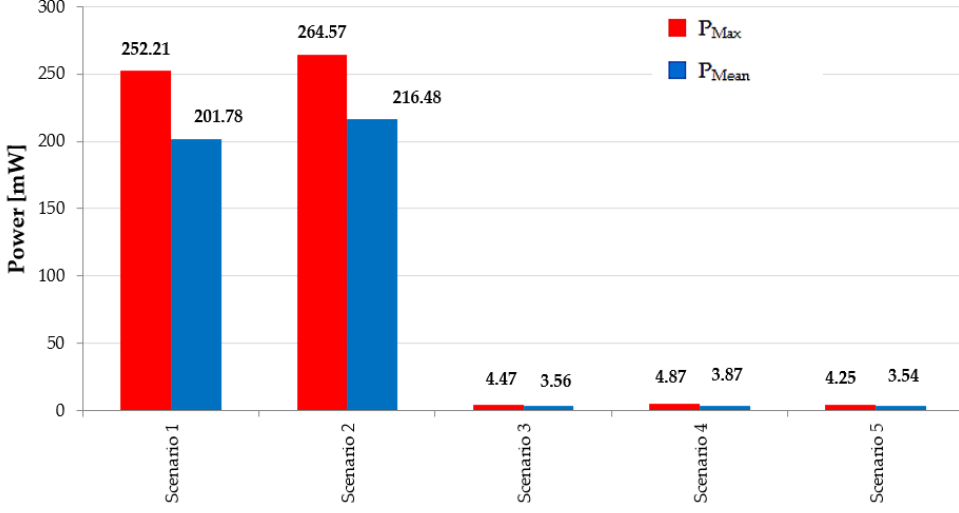
Figure 17. Maximum and mean power provided by the multisource harvesting section equipped in the wearable device as a function of the operating conditions.